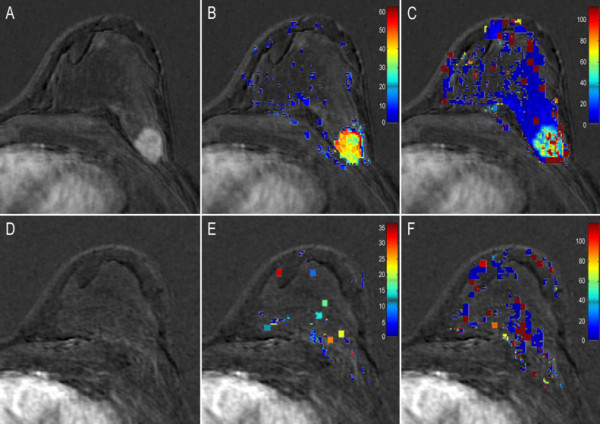
Images show changes in transfer constant (Ktrans) in patient 22, complete responder to neoadjuvant chemotherapy (Sataloff A). Columns show in A and D: anatomic subtraction images; in B and E: corresponding Ktrans map acquired using measured Arterial Input Function (AIF); and in C and F: corresponding Ktrans map acquired using theoretical AIF. Images A, B, and C show data before neoadjuvant chemotherapy treatment and images D, F, and G are post-treatment. After treatment a decrease of -98% is seen in Ktrans using measured AIF values and a decrease of -29% using theoretical AIF values. Note the difference between Ktrans values before treatment when using measured and theoretical AIFs. To increase visibility of the color encoded Ktrans pixels the scale was reduced in postchemotherapy images.